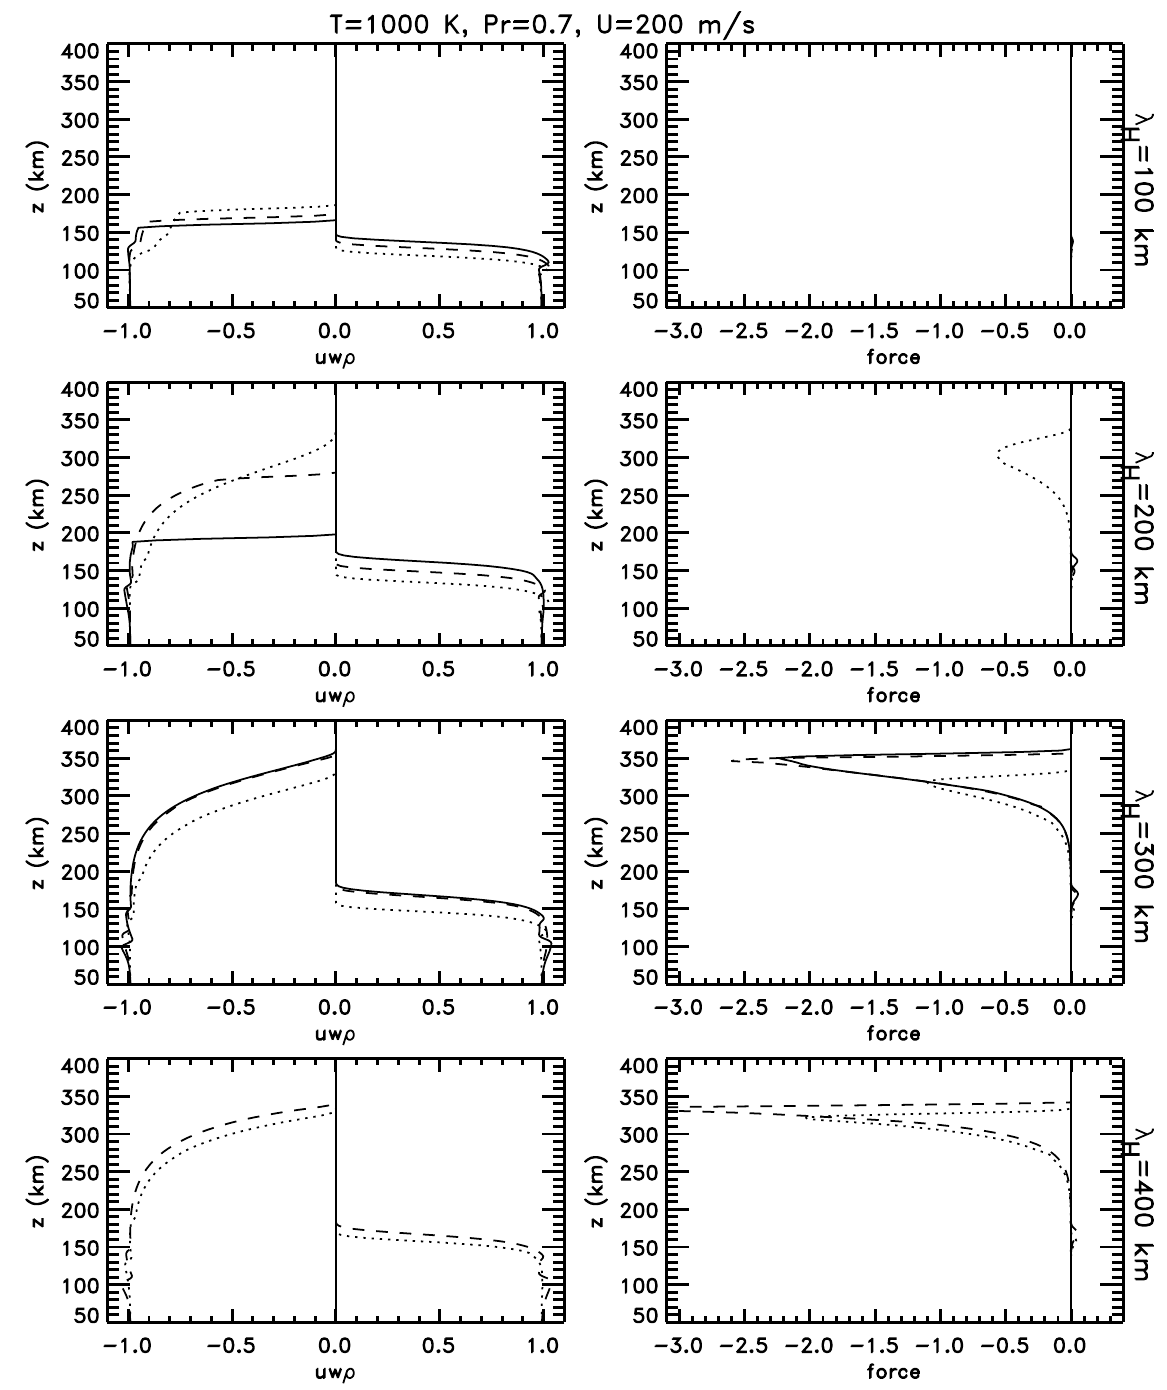
Fig. 11. As in Fig. 10, but for a thermospheric zonal wind of 200ms − 1 .